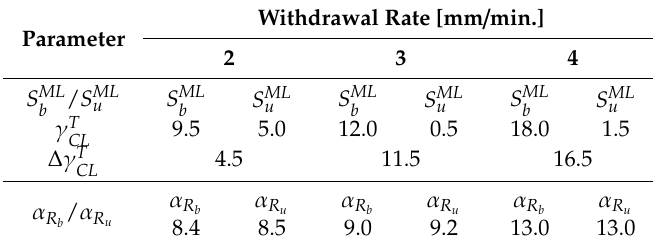
and M is the width of the ML. The vector situated between points 0 and 1 indicates the PA direction. The crossed small arrows in the grey circle indicate the directions of the secondary dendrite